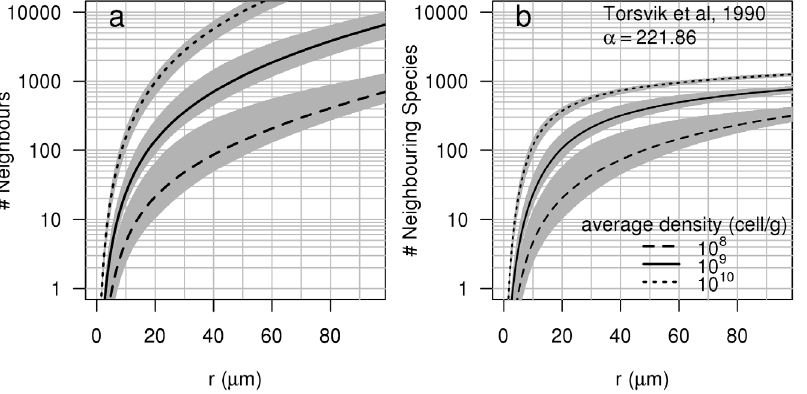
Figure 3. Number of neighbours and neighbouring species. (a) Mean number of neighbours and (b) neighbouring species around an ‘‘average’’ bacterium as a function of distance from the bacterium and as a function of bacterial density. The mean number of neighbours and neighbouring species are derived from Ripley’s K(r) function of LGCP with parameters m = 2 10.26, s 2 =2.90, b =20 for the 10 8 cells g 2 1 soil density, m = 2 7.52, s 2 =1.90, b =25 for the 10 9 cells g 2 1 soil density and m = 2 4.91, s 2 =1.29, b =25 for the 10 10 cells g 2 1 soil density. Grey envelopes surrounding curves represent the maximum and minimum of these numbers calculated from 39 simulations. Note the logarithmic scale on the y axis.